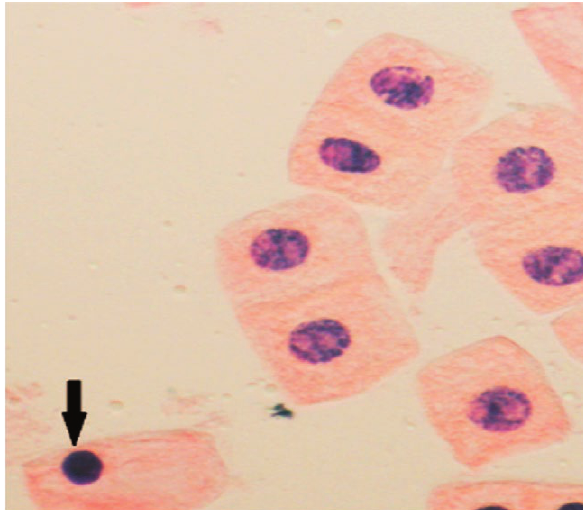
Figure 3. Heteropicnotic nucleus (arrow) in Allium cepa meris- tematic root cells after exposure to the decoctions of Aristolochia labiata . 1000x magnification.